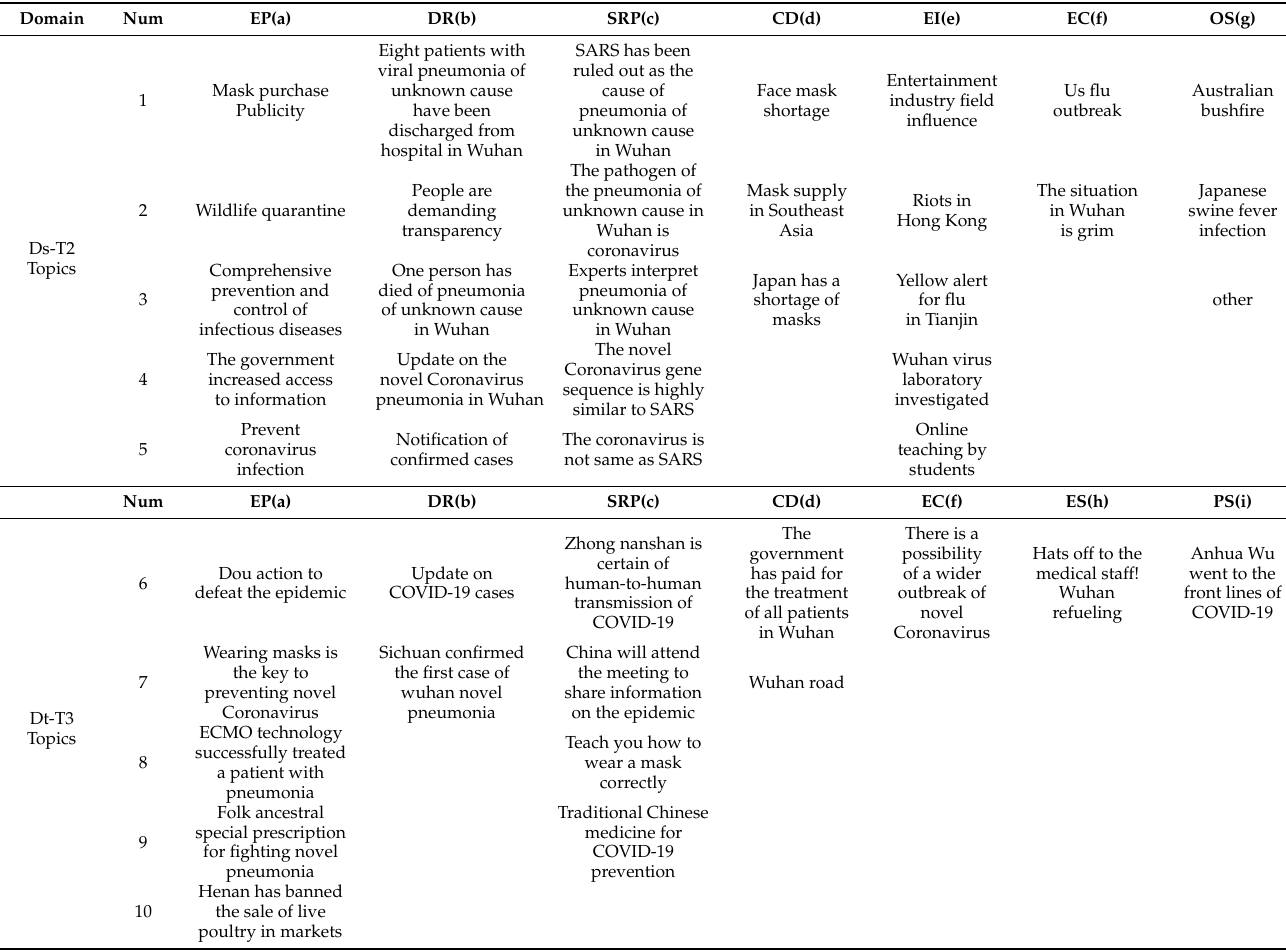
Table 7. Topic extraction results extracted by single-pass in T2 and